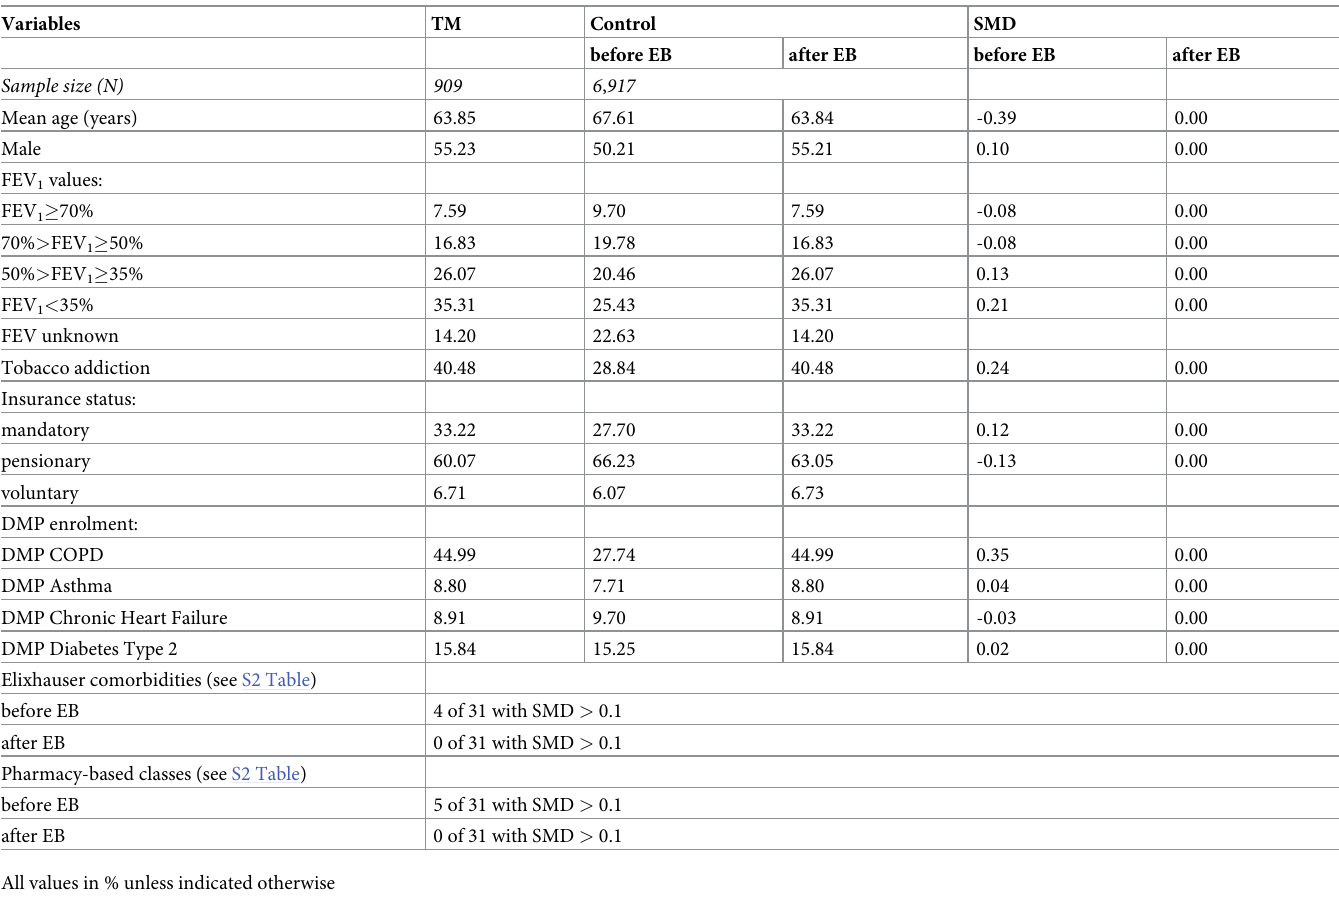
Table 1. Baseline characteristics of telemonitoring (TM) and control group before and after entropy balancing (EB). Variables